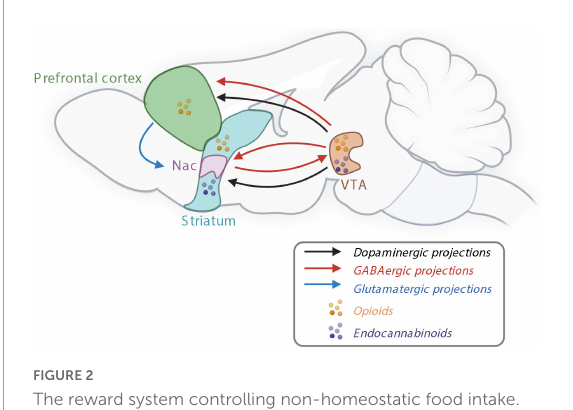
FIGURE2 The reward system controlling non-homeostatic food intake. Nac, nucleus accumbens; GABA, γ -aminobutyric acid; VTA, ventral tegmental area. Created with